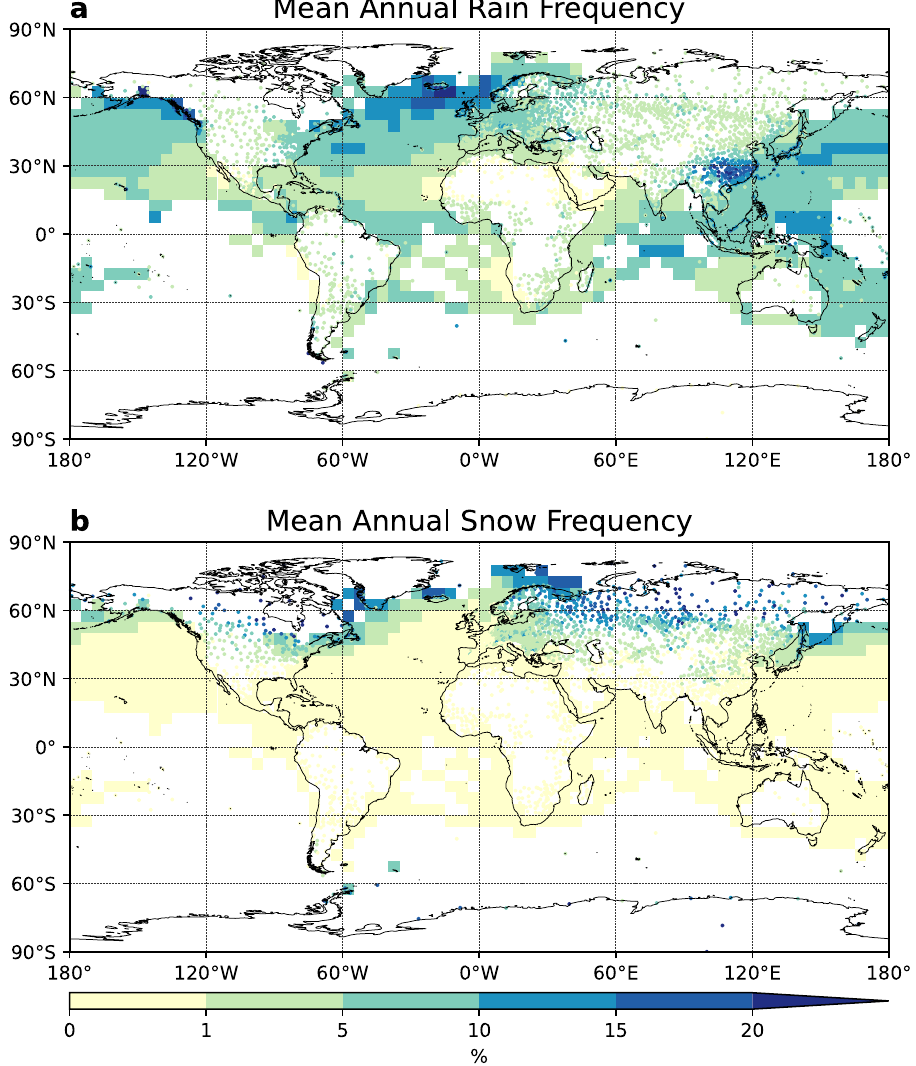
Figure 2. Mean annual rain and snow frequency of occurrences. ( a ) Mean annual rain frequency. ( b ) Mean annual snow frequency. Rain (snow) frequency of occurrence was calculated for each year, then the 42-year mean were computed for 1978–2019. This figure was plotted using Python 3.7.4 (https:// www. python. org/ downl oads/ relea se/ python-